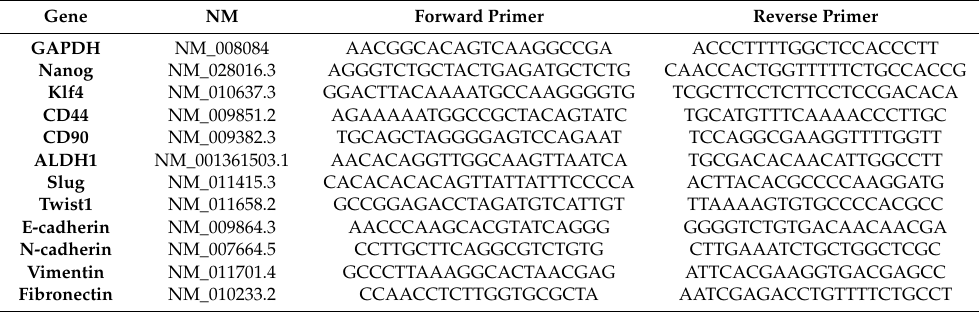
Table 1. Primers used in RT-qPCR